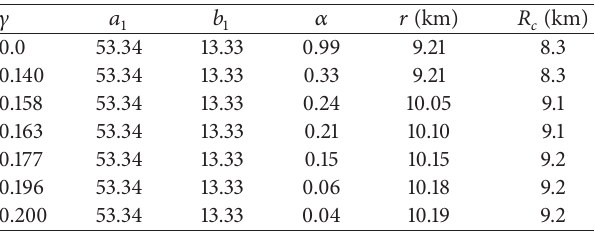
Table 4: Stability of PSR J1614-2230 when 𝑠 1 = 14.5 and 𝛼 , 𝛾 are